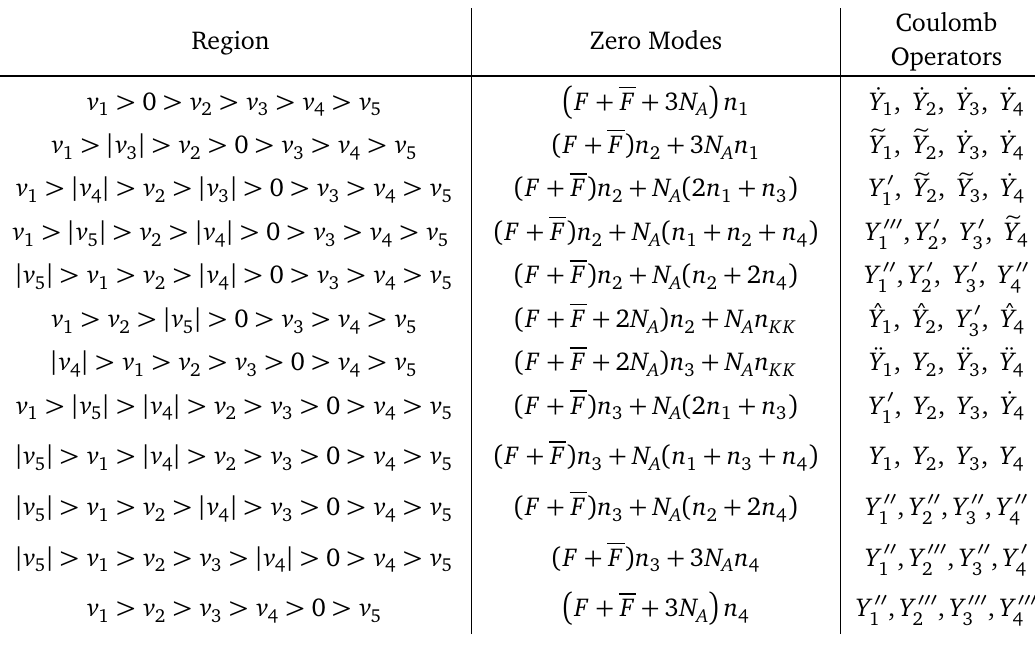
Table 8: Regions of the fundamental Weyl Chamber of SU ( 5 ) where F = F + 1 and = N A